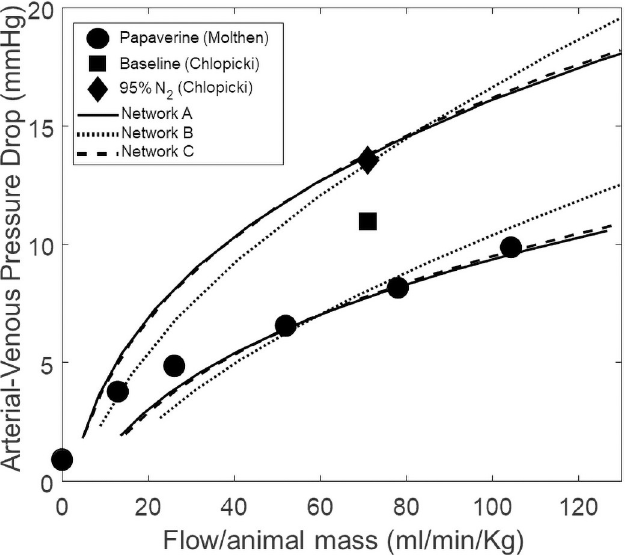
Fig 4. Whole-organ pressure-flow relationships. Discrete data points are taken from isolated-perfused-ventilated lung experiments performed in Molthen et al. [50] and Chlopicki et al. [20]. Simulations are run under Zone 3 conditions (venous outlet pressure (7 mmHg) > alveolar pressure (6 mmHg)). The model simulation curves that are near the 95% N 2 (Chlopicki) data point were run with T � = 0.8, and the curves near the Papaverine (Molthen) data points were run with T � =